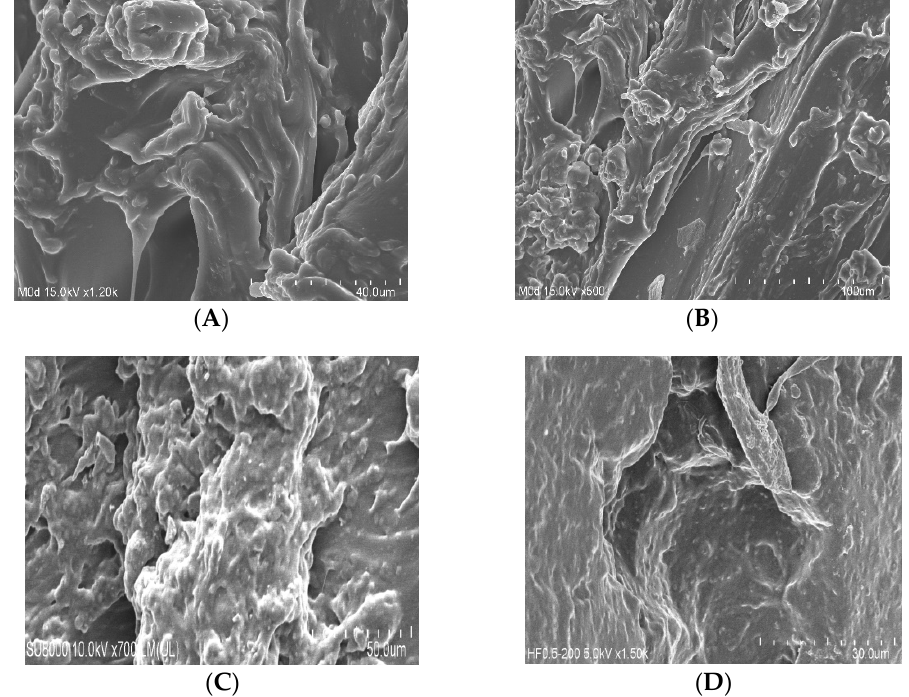
Figure 5. Scanning electron microscopy of different formulations of the Cs/SpsCpAca hydrogel with the increasing concentration of ( A , B ) Cs, ( C ) Sps, and ( D ) Aca.